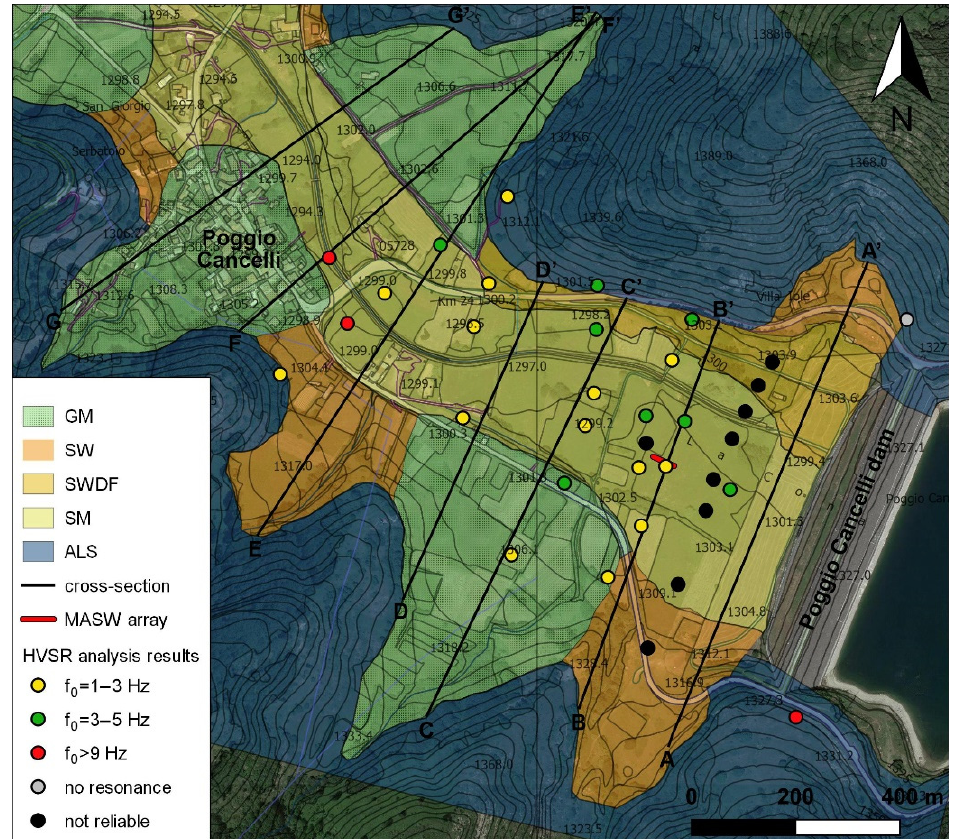
Figure 8. Engineering-geological map with geophysical investigations of the Poggio Cancelli valley. Legend: GM: alluvial fans; SW: eluvial-colluvial deposits; SWDF: debris deposits; SM: tilled soil and anthropic material; ALS: Laga Fm. flysch.